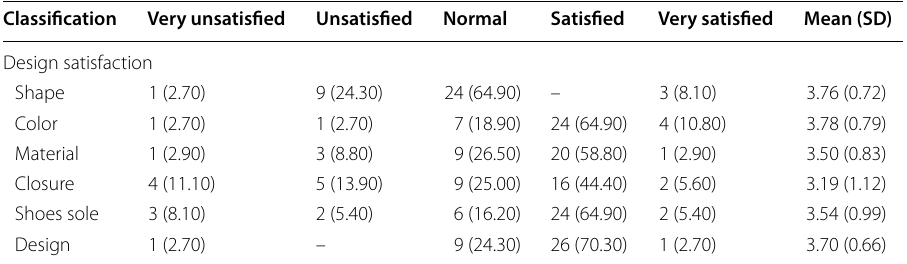
Table 5 Design satisfaction of improved design prototype (N/%)